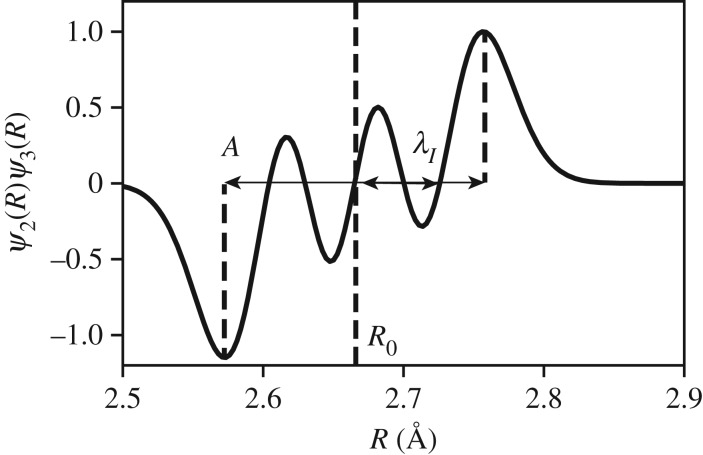
We show ψv(R)ψv+1(R) using v = 2 and v = 3. There are three notable spatial features of this wave function: the central position R0, the amplitude of oscillation A and the wavelength between nodes, λI. Only R0 impacts the structure of scattering at low Q as shown in figure 9. Note that (v =  2, v + 1 = 3) are chosen for discussion not because they may be fingerprinted in the experimental data but because ψ2(R)ψ3(R) clearly highlights the difference between A and λI.